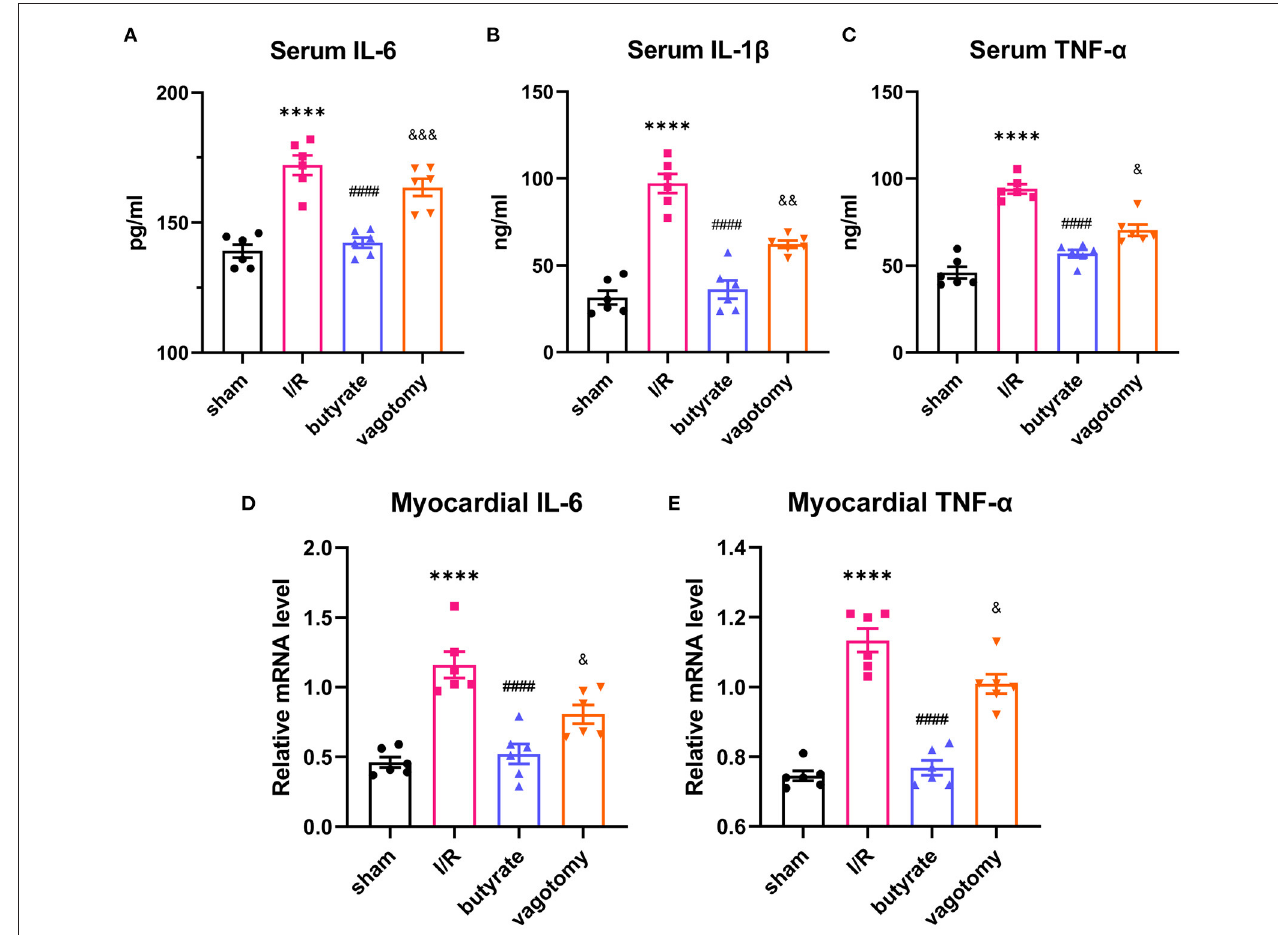
FIGURE 3 | Butyrate treatment inhibited inflammation in the heart and serum after myocardial I/R, and vagotomy diminished this protective effect. (A) Serum IL-6, (B) serum IL-1 β , and (C) serum TNF- α levels. (D) Myocardial IL-6 and (E) TNF- α relative mRNA levels. **** p < 0.0001 vs. sham group; #### p < 0.0001 vs. I/R group; & p < 0.05, && p < 0.01, &&& p < 0.001 vs. butyrate group. IL-6, interleukin-6; IL-1 β , interleukin-1 β ; TNF- α , tumor necrosis factor- α ; I/R,